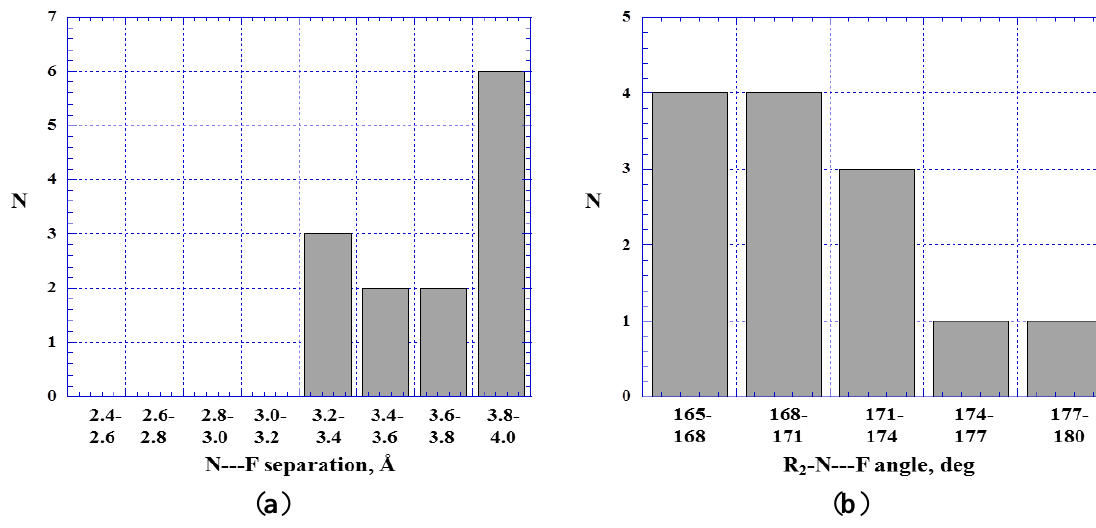
Figure 13. Histograms showing numbers N of R separations ( a ) and R –N---F angles ( b ). 2